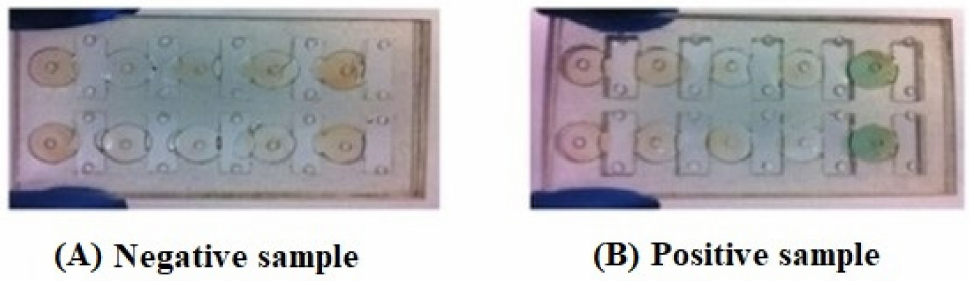
Figure 3. The results of the prostate cancer detection by using the HRP substrate [ABTS (2,2 (cid:48) -Azinobis [3- ethylbenzothiazoline-6-sulfonicacid]-diammonium salt) to track the presence of the prostate specific antigen (PSA) in serum, ( A ) the negative sample (No PSA) where the HRP substrate still stays as a red colour and ( B ) the positive result (PSA presence) where the HRP substrate develops a green colour